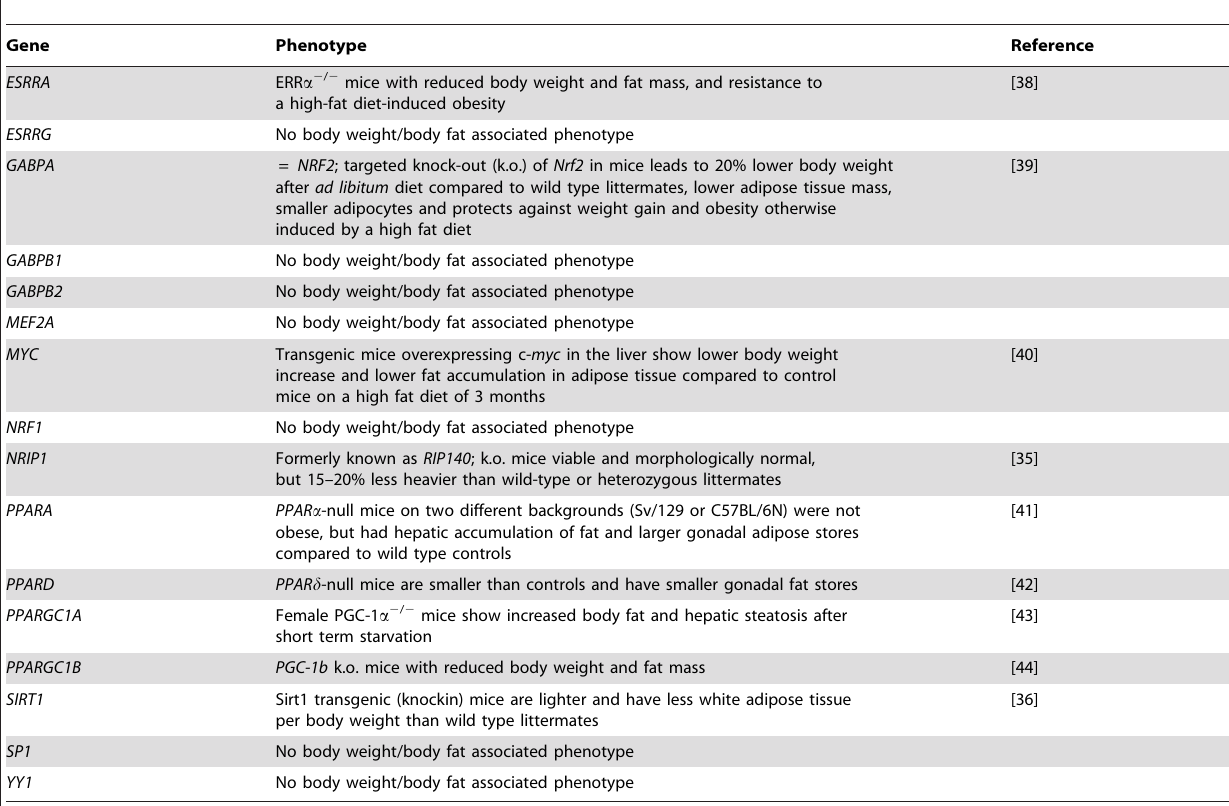
Table 4. Animal models (knockout, alterations in the expression and mutations) of the nuclear regulators of mitochondrial genes (gene set 1) in relation to obesity or related